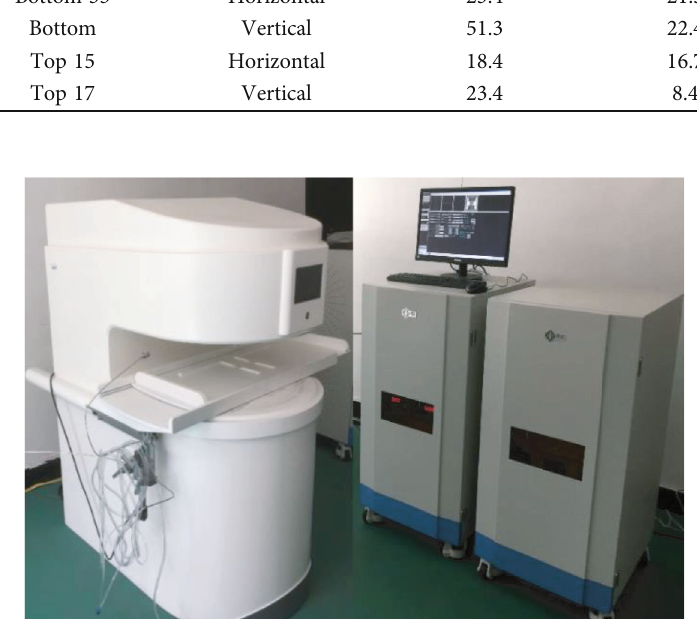
Figure 2: NMR instrument.